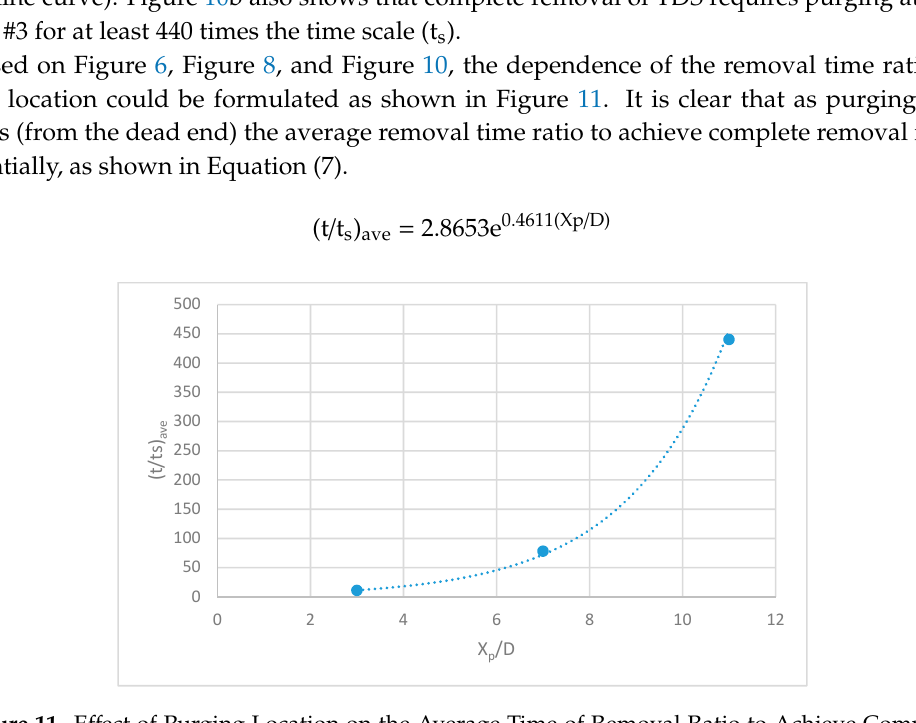
Figure 10. ( a ) Effect of Re and Purging Flow Rate on Time of TDS Removal Ratio (Zone 1, Xp/D = 11) and ( b ) average Time of Removal Ratio for Achieving a Specified % of TDS Removal (Xp/D = 11).